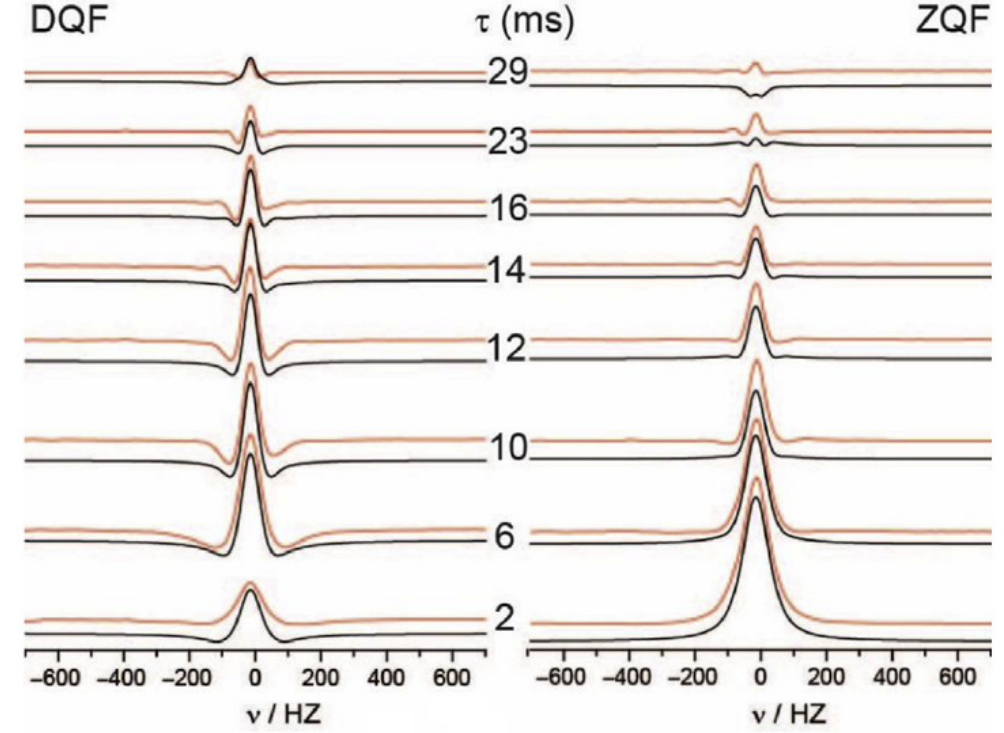
Figure 18. Deuterium DQF/ZQF NMR spectra of a Nafion membrane, hydrated to 15 D 2 O molecules per sulfonate group. Reprinted with permission from [165]. Copyright 2018, Elsevier.